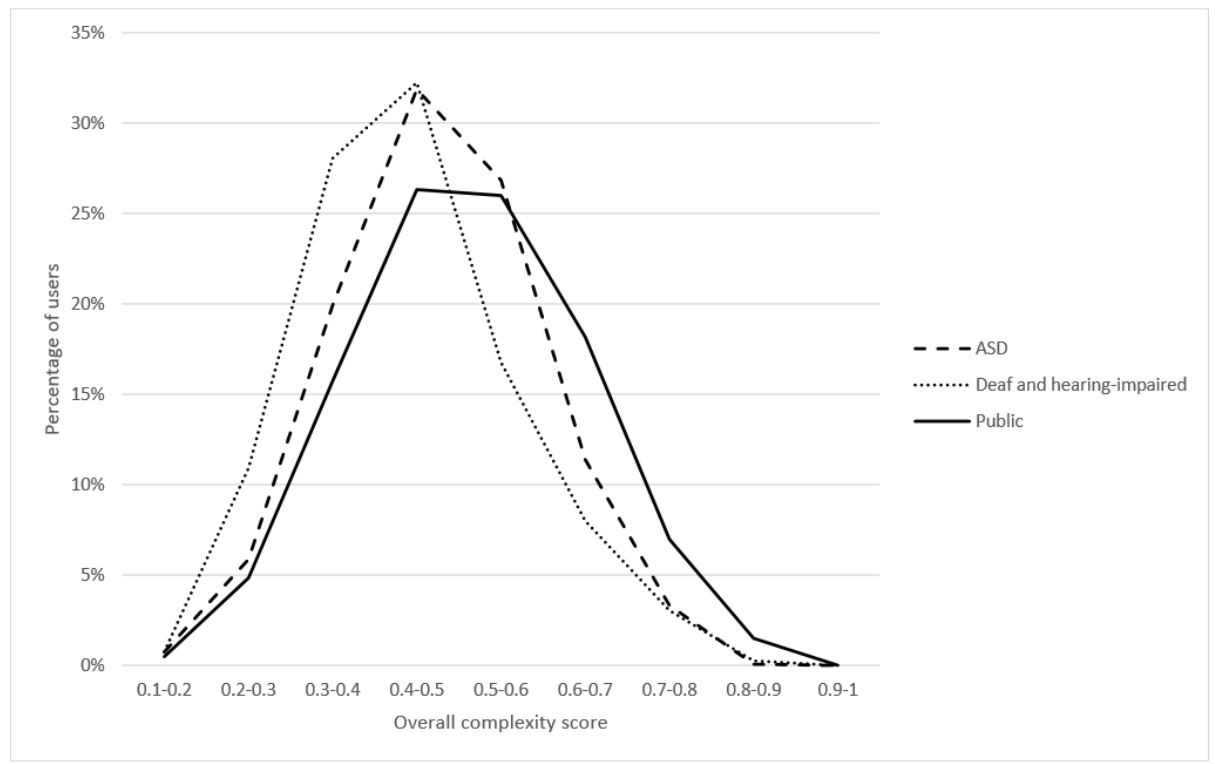
Figure 6. Overall complexity comparison for users in the 3 health corpora. ASD: autism spectrum